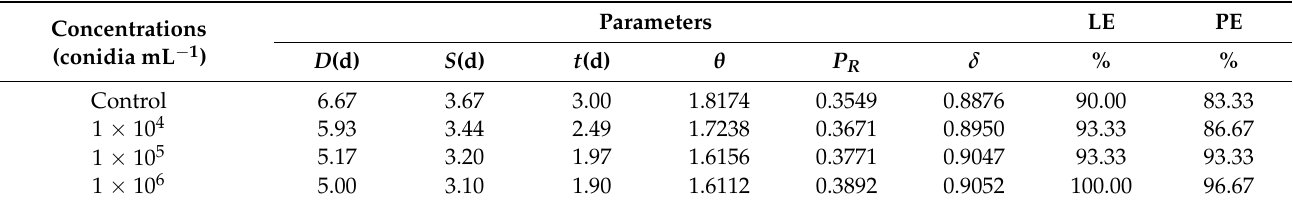
Table 1. LE and PE of S. guani on the larvae of M. alternatus under different concentrations of B. bassiana spore suspensions.